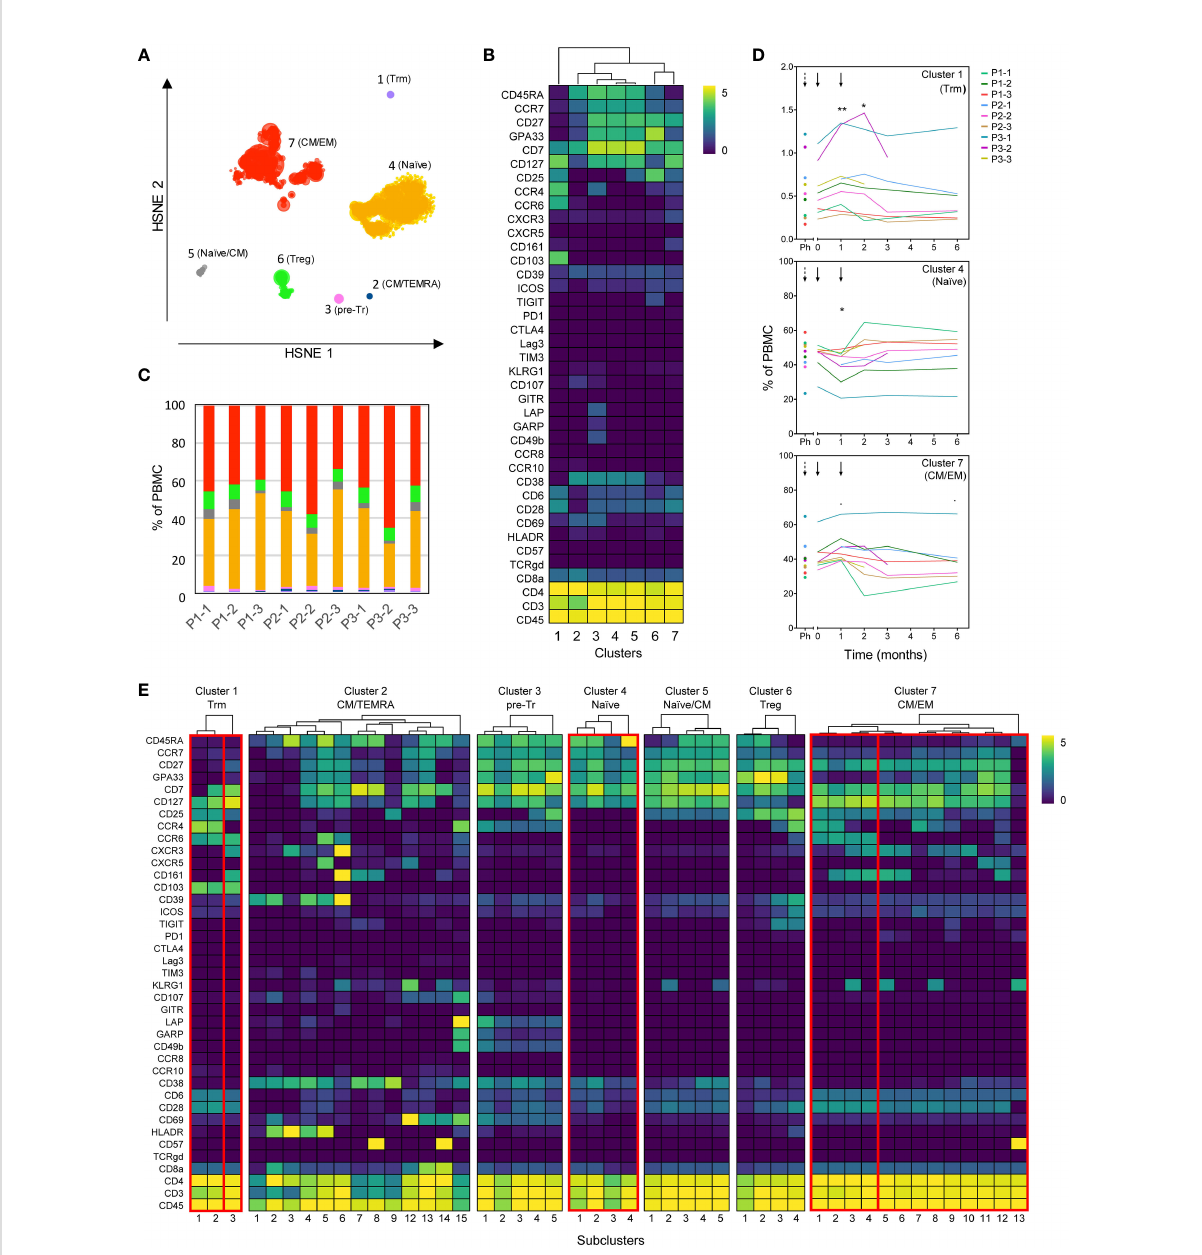
FIGURE 5 High dimensional analysis of the CD4 + T-cell compartment reveals changes after tolDC treatment. Analysis of CD4 + T-cells from tolDC-treated patients containing multiple timepoints before and after tolDC treatment (n=9). (A) HSNE analysis reveals seven major CD4 + T-cell clusters at the overview level (level 1). (B) Clustered heatmap displays the phenotype of major clusters. (C) Distribution of major clusters within each patient (all timepoints combined). Colors correspond to the HSNE map in (A) . (D) Line plots display frequency of clusters for individual patients in time. The frequency in clusters 1, 4 and 7 signi fi cantly changed after tolDC treatment (cluster 1; p=0.012, cluster 4; p=0.007 and cluster 7; p=0.010). Black arrows show time of fi rst and second tolDC injection, dashed arrows indicate the timepoint before leukapheresis. Each line represents one patient. (E) The heterogeneity within each major cluster is further explored in a new HSNE analysis (level 2). Generated subclusters are visualized in a heatmap. Boxes indicate signi fi cant major- and subclusters. Line plots with change in time of signi fi cant subclusters are displayed in Figure S5. Asterisks in (D) indicate signi fi cance levels for individual timepoints, *p<0.05 and